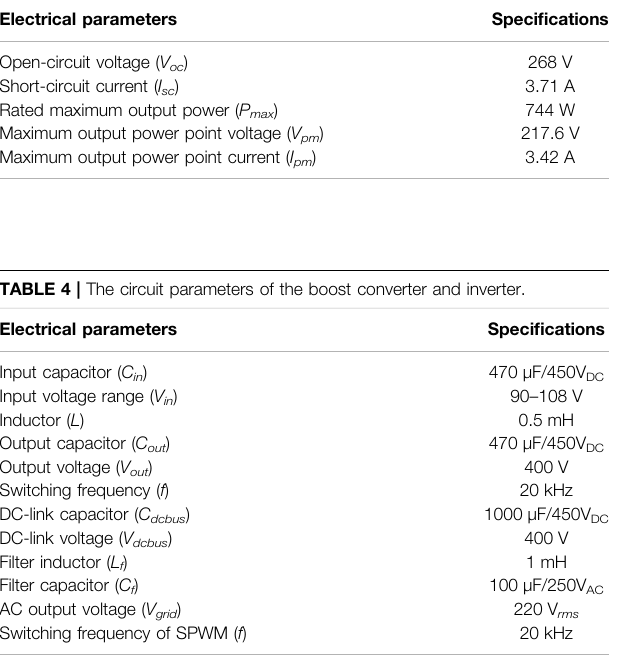
TABLE 3 | Electrical speci fi cations of SANYO HIP-186BA19 photovoltaic module